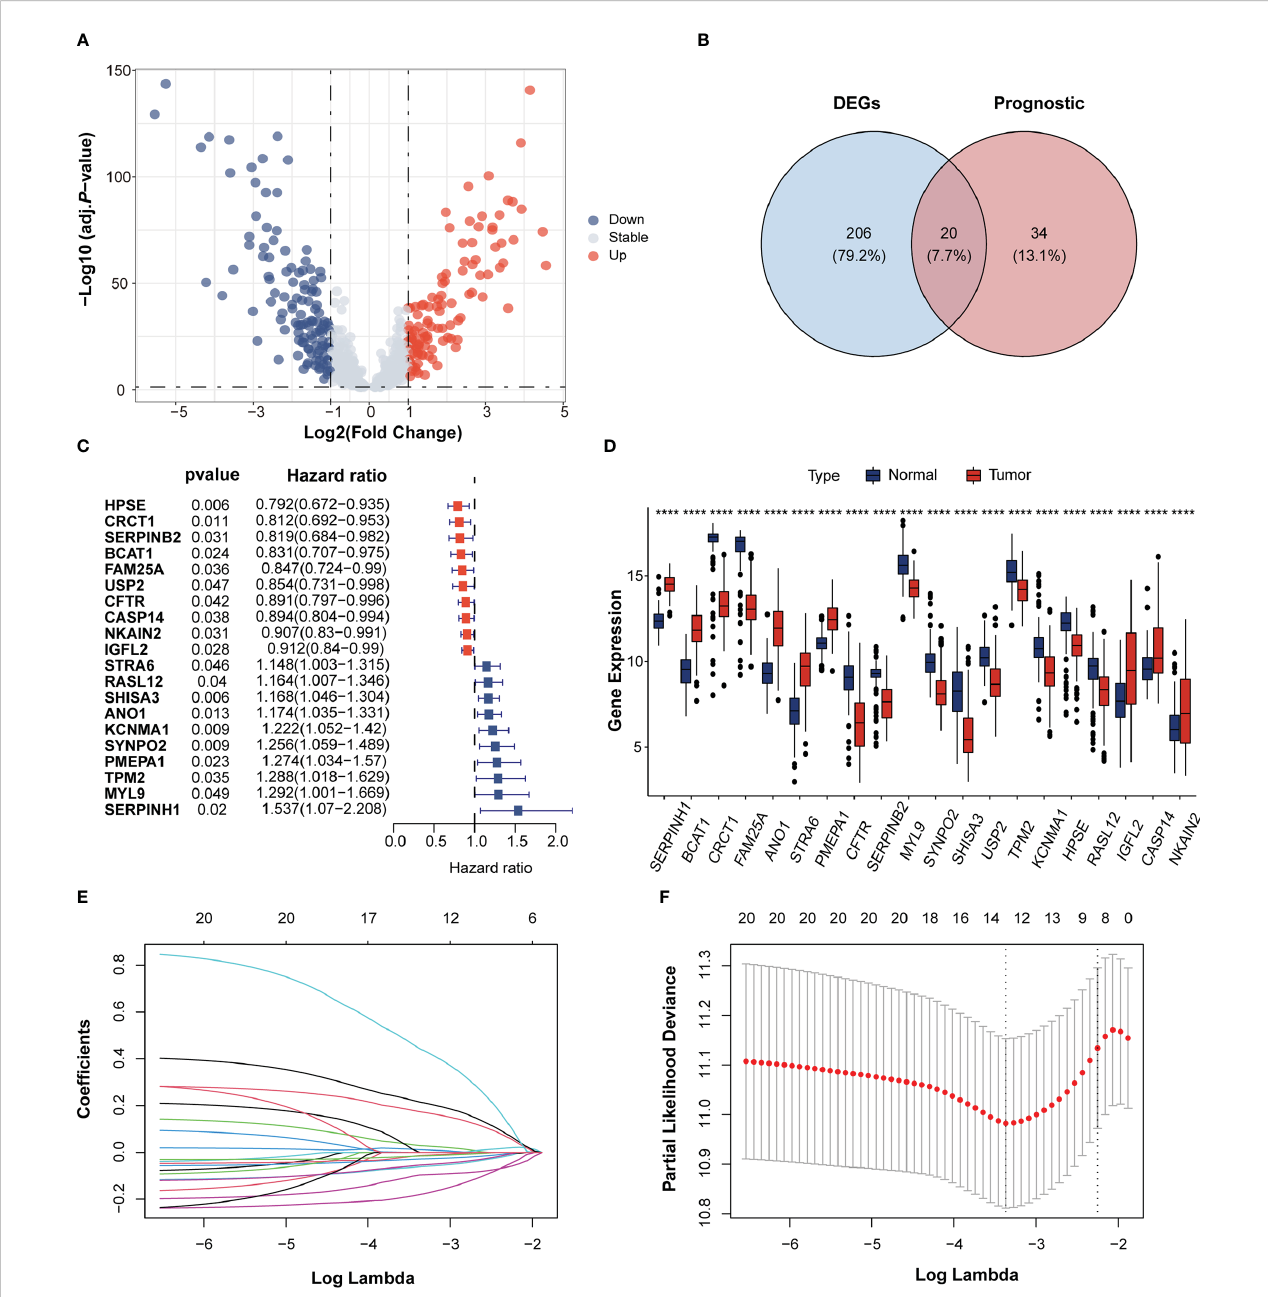
FIGURE 1 Identi fi cation of immunotherapeutic response-related genes in Esophageal squamous-cell carcinoma (ESCC). (A) Volcano plot of immunotherapeutic response related genes in the GEO cohort. The blue and red dots indicate down- and upregulated genes. (B) Venn diagram of the intersection between the differentially expressed genes and prognostic genes. (C) Forrest plot of the univariate Cox regression analysis of 16 overlapping genes. (D) The gene expression of 20 overlapping genes between ESCC and normal tissues. Tumor, red; Normal, blue. **** p < 0.0001; ns, no statistical signi fi cance; GEO, Gene Expression Omnibus. (E) LASSO coef fi cient pro fi les of 10 candidate genes. (F) Cross-validation for tuning parameter selection in the LASSO